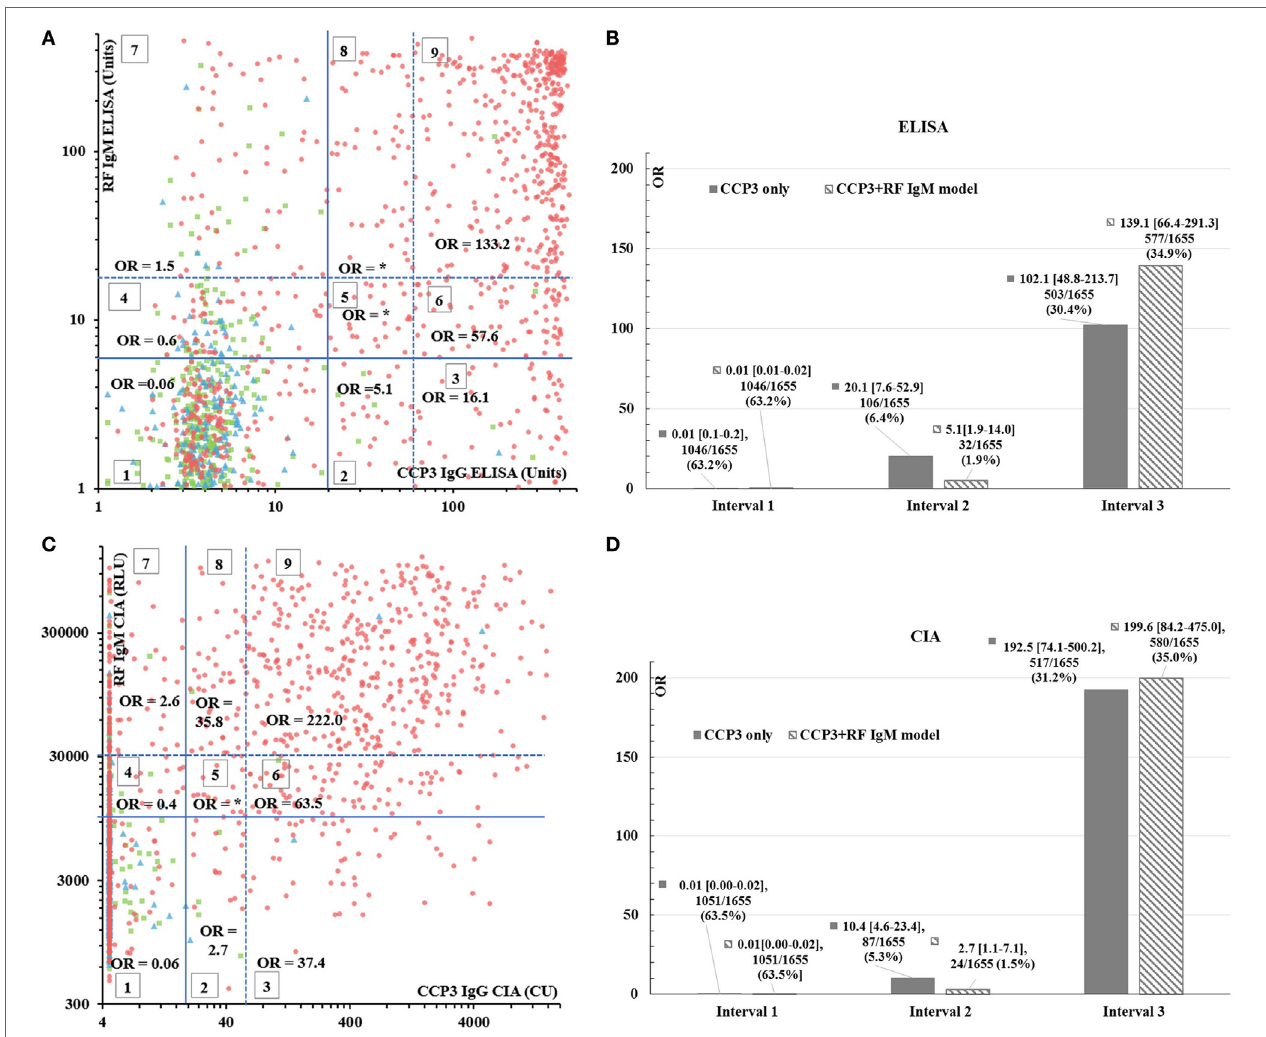
FigUre 2 | RF IgM and CCP3 combinatory model. Panels (a,c) represent the scatter plots for the RF IgM and CCP3 combination on ELISA (a) and CIA (c) . The red dots represent patients with RA, the green squares are patients with axSpA and the blue triangles show patients with PsA. The lines sectioning the graphs into nine groups represent the manufacturer’s cutoffs (solid line) or the preliminary cutoffs for the RUO assay and the 3 × ULN (dashed). The different sections of the graph are indicated by numbers (1–9). The x and y -axes are shown in logarithmic scale. Panels (B,D) show the OR, 95% CI, number and percentage of patients for the individual CCP3 assays (solid) versus the combined model of CCP3 and RF IgM (dashed) in the three intervals on ELISA (B) and CIA. *Note: OR could not be calculated since no controls were found in those groups. Abbreviations: CU, chemiluminescent units; RLU, relative light units; CO, cutoff; ULN, upper limit of normal; OR, odds ratio; RF, rheumatoid factor; CIA, chemiluminescent immunoassay; ELISA, enzyme-linked immunosorbent assay; RA, rheumatoid arthritis; axSpA, axial spondyloarthritis; RUO, research use